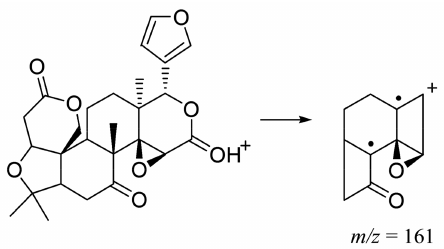
Figure 4. The fragmentation of